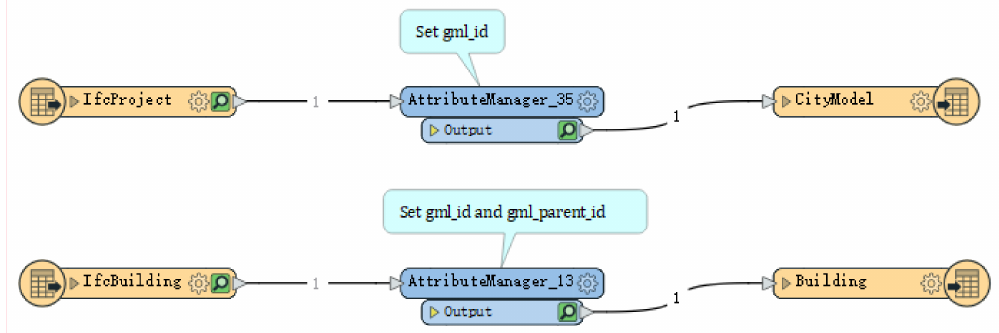
Figure 17. Setting of attribute data of CityGML